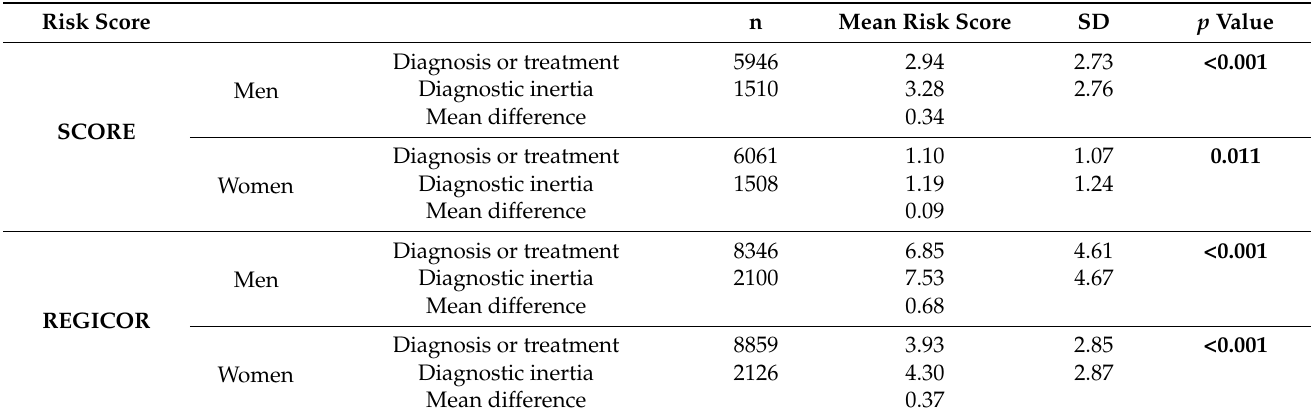
Table 5. SCORE and REGICOR cardiovascular risk scores, according to inertia and sex.